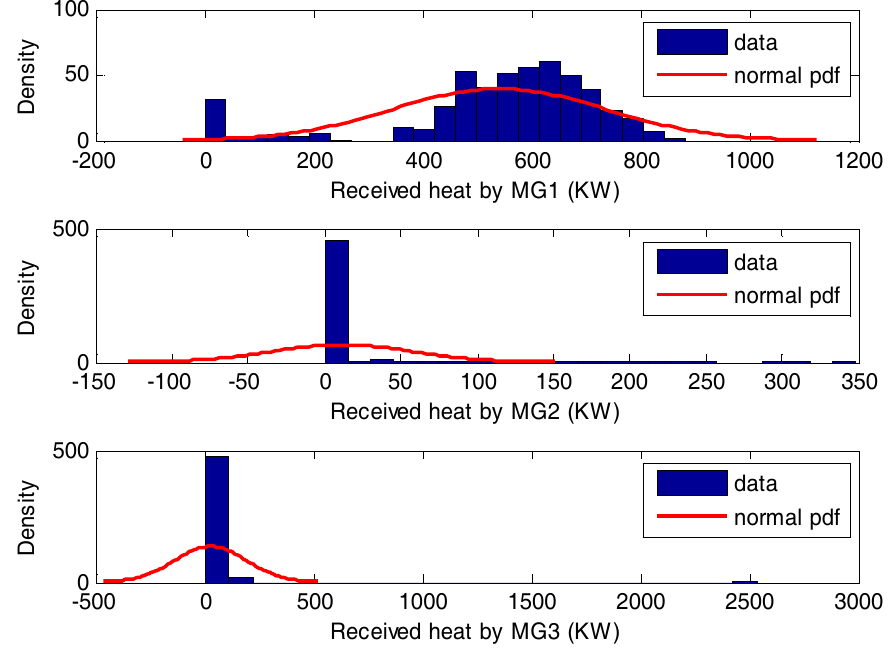
Figure 7. PDF of received heat by each MCMG. Top: MCMG1; Middle: MCMG2, Bottom: MCMG3.